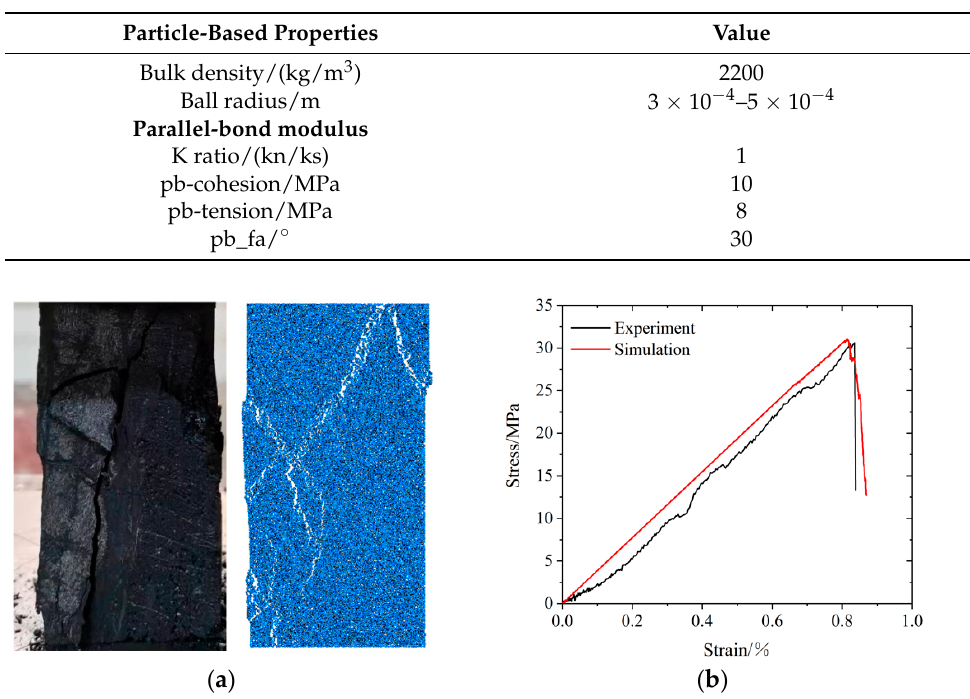
Figure 5. Schematic diagram of SHPB simulation model.